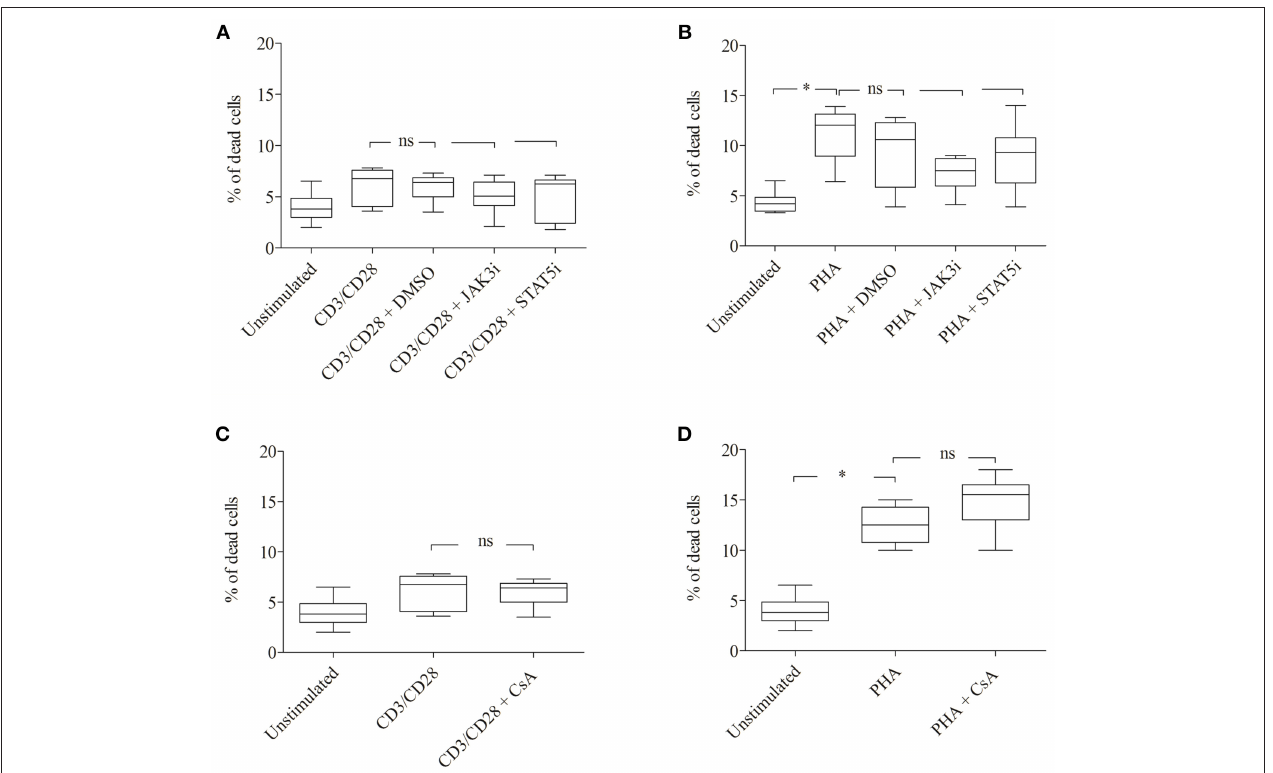
FIGURE 5 | Effect of JAK3, STAT5 inhibitors and cyclosporine (CsA) on cell viability. CD3/CD28 or PHA stimulated T cells were treated with DMSO (0.07 %), JAK3i (12 µ M), STAT5i (35 µ M) (A,B) or CsA (500nM) (C,D) for 72h. The percentage of dead cells was calculated after 7-AAD staining. The bold line inside each box plot shows the median, upper, and lower lines indicate the maximum and minimum values, respectively (Curves were evaluated by the non-parametric Friedman test). Ns, no significant; * p < 0.05 (Wilcoxon’s test); n = 6 independent experiments; Jak3i, Janus kinase 3 inhibitor; STAT5i, signal transducer and activator of transcription 5 inhibitor.